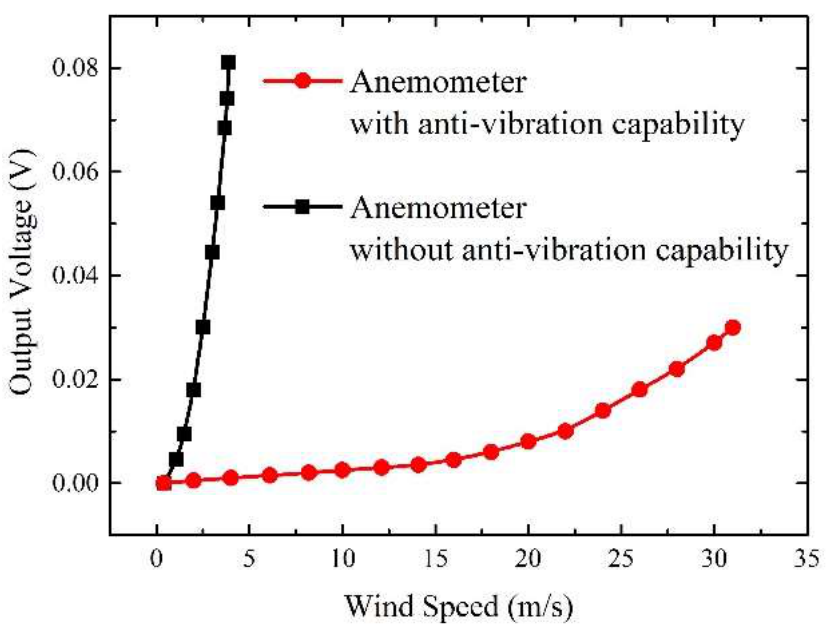
Figure 7. Experimental output voltage versus wind speed characteristics for the anemometers with or without vibration suppression capability.